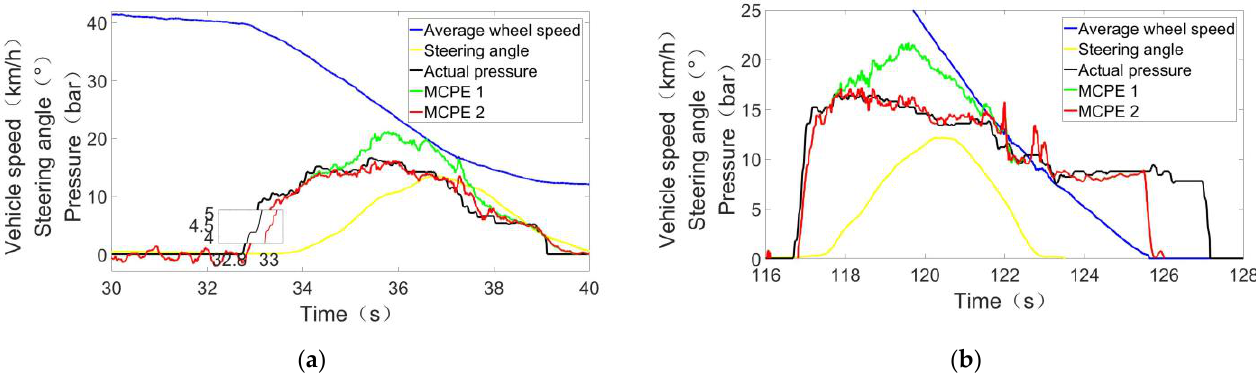
Figure 3. Test results of MCPEs based on difference vehicle models: ( a , b ) represent different brake conditions.